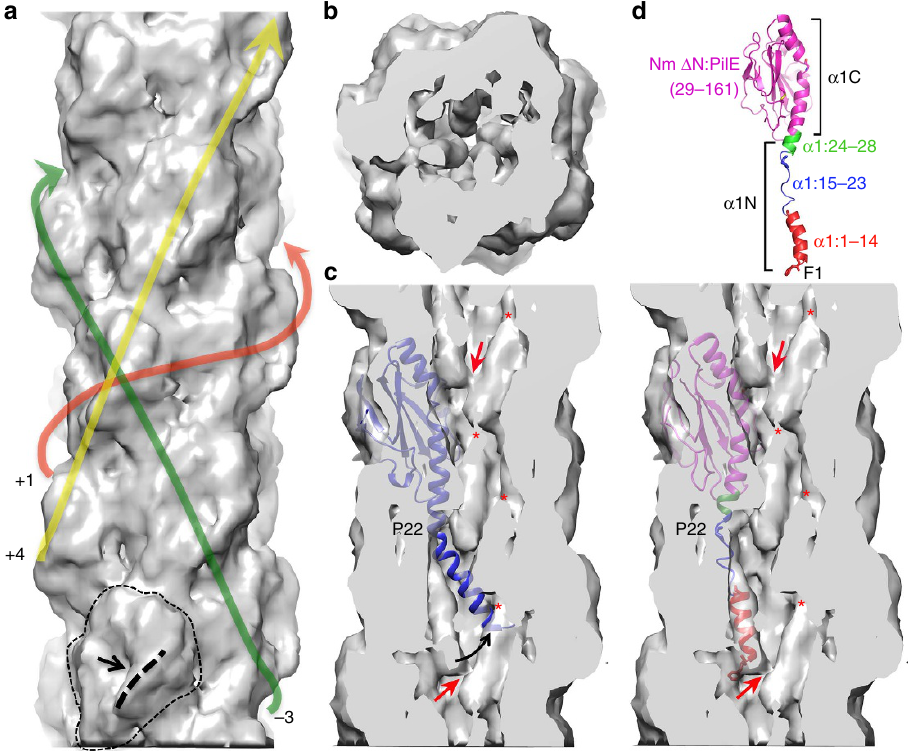
Figure 3 | CryoEM reconstruction of the N. meningitidis T4P at 6Å resolution. ( a ) Side view of the Nm pilus cryoEM map showing the globular domain density and its connectivity in the right-handed 1-start helix ( þ 1), the right-handed 4-start helix ( þ 4) and the left-handed 3-start helix ( (cid:2) 3). A single globular domain is outlined at the bottom of the map, with the ridge indicated with a thick dashed line and the central depression indicated with an arrow. ( b ) End view of a section of the cryoEM map showing the rod-like density corresponding to N-terminal a -helices. ( c ) Cross section of the Nm pilus reconstruction showing the rod-like a -helical density, the ends of which are connected near the central filament axis (red arrows). The full-length Ng PilE structure (2HI2) was fit as a rigid body into the globular domain density. The Pro22-induced kink results in the N-terminal a -helical segment completely missing the rod-like density. The rod-like density disappears just before it enters the globular domain density (red asterisks). ( d ) The Nm PilE structure was fit into the map in segments, as indicated. a 1N was modelled from the corresponding region in the Ng PilE crystal structure, with the helix melted in a 1:15–23, which straightens a 1. Table 2 | Refinement statistics for the Ng T4P filament model.